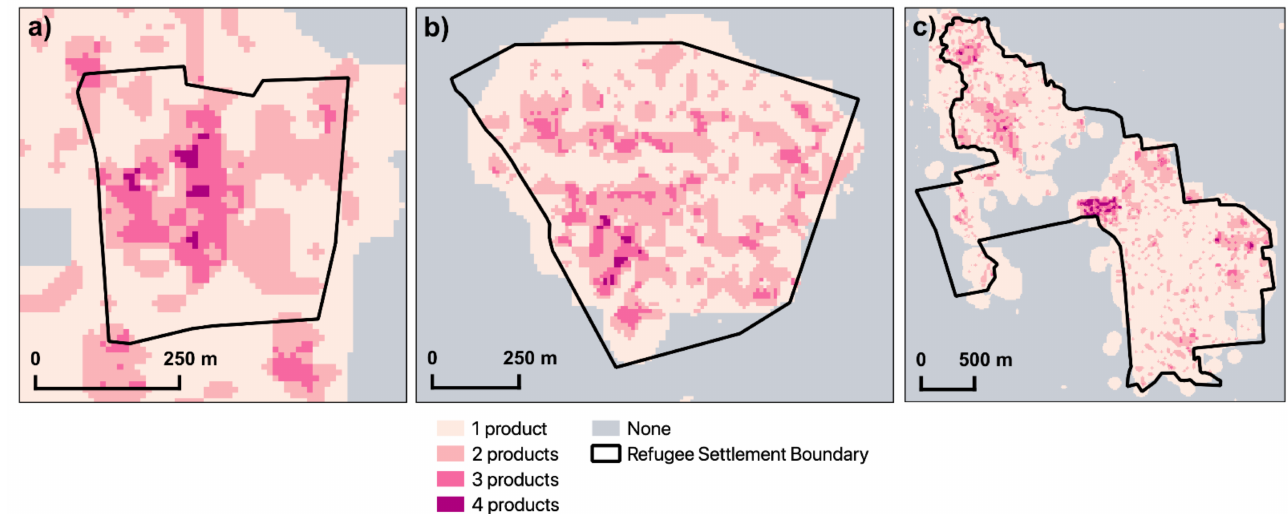
Figure 12. Maps of agreement among four settlement products at ( a ) Mireyi, ( b ) Boroli I and ( c ) Ayilo I: “1 product” indicates unique coverage by a single product; “2 products”, “3 products” and “4 products” indicate the number of settlement products that share coverage; “None” indicates zero coverage. Note that the spatial scale of settlement maps